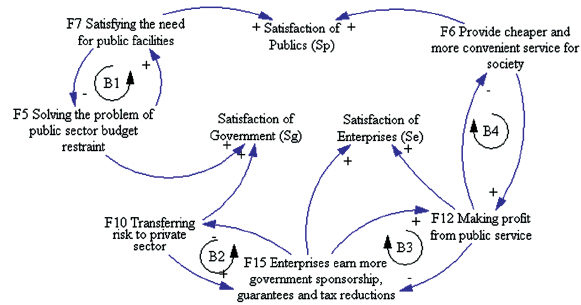
Figure 1: B1, “solving the problem of public sector budget restraint ( F )” has positive influence on “satisfying the 5 need for public facilities ( F )”, but the latter has nega- 7 tive influence in return because the investment in pub - lic facilities could cause government’s budget